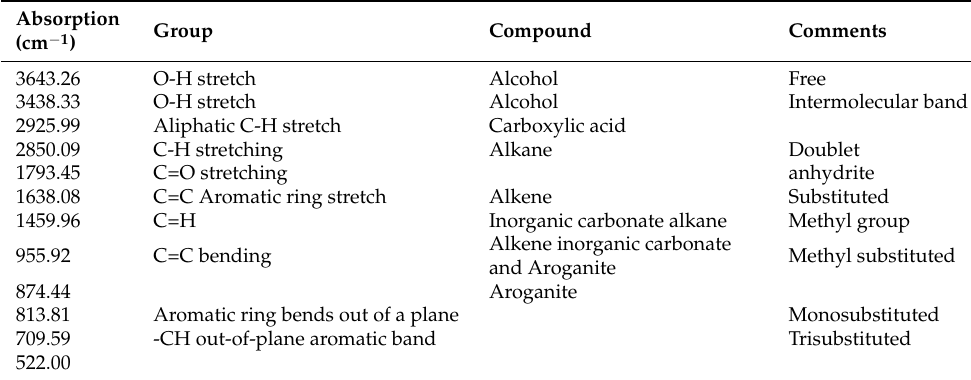
Table 2. Band assignment for FTIR spectra.